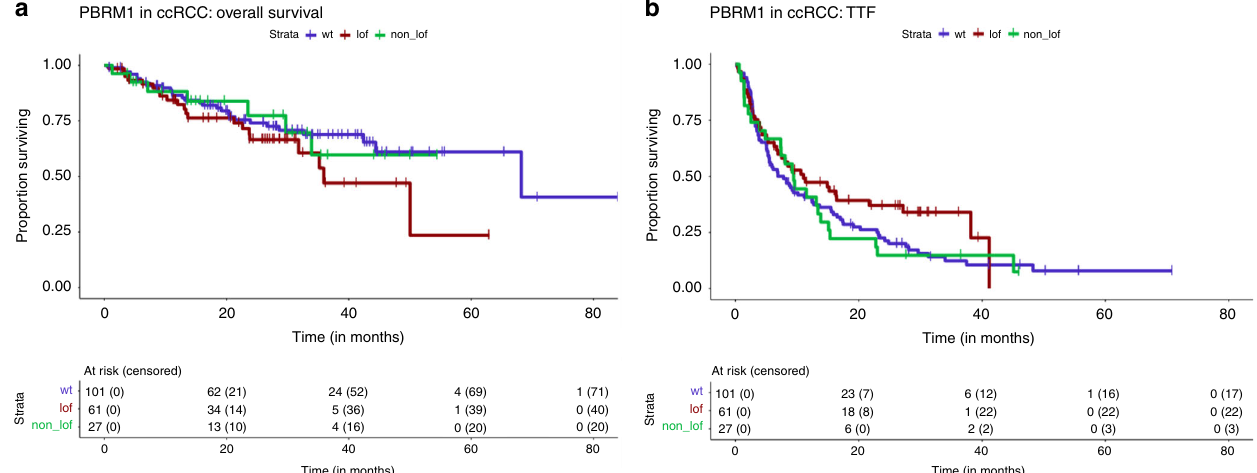
Fig. 4 Survival and time to treatment failure in PBRM1 mutated MSKCC ccRCC patients. Kaplan – Meier curves demonstrating overall survival (median 68.2 months; 95% CI 44.4, NA) and time-to-treatment failure (TTF) (median 8.9 months; 95% CI 6.9, 12.42) in clear cell RCC patients across MSK-